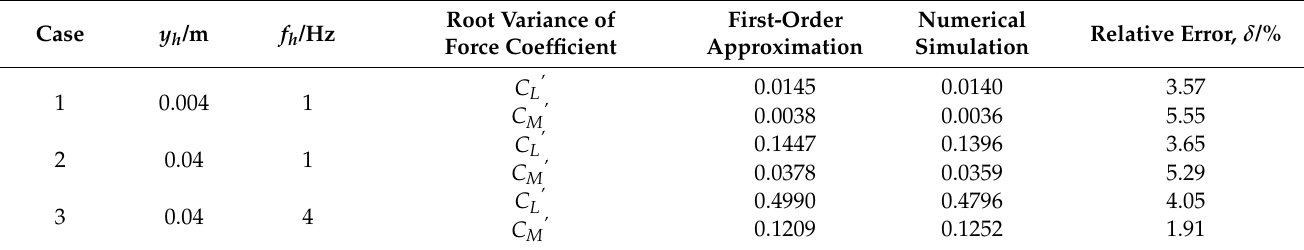
Table 1. Parameters of heaving motion and comparisons of results.